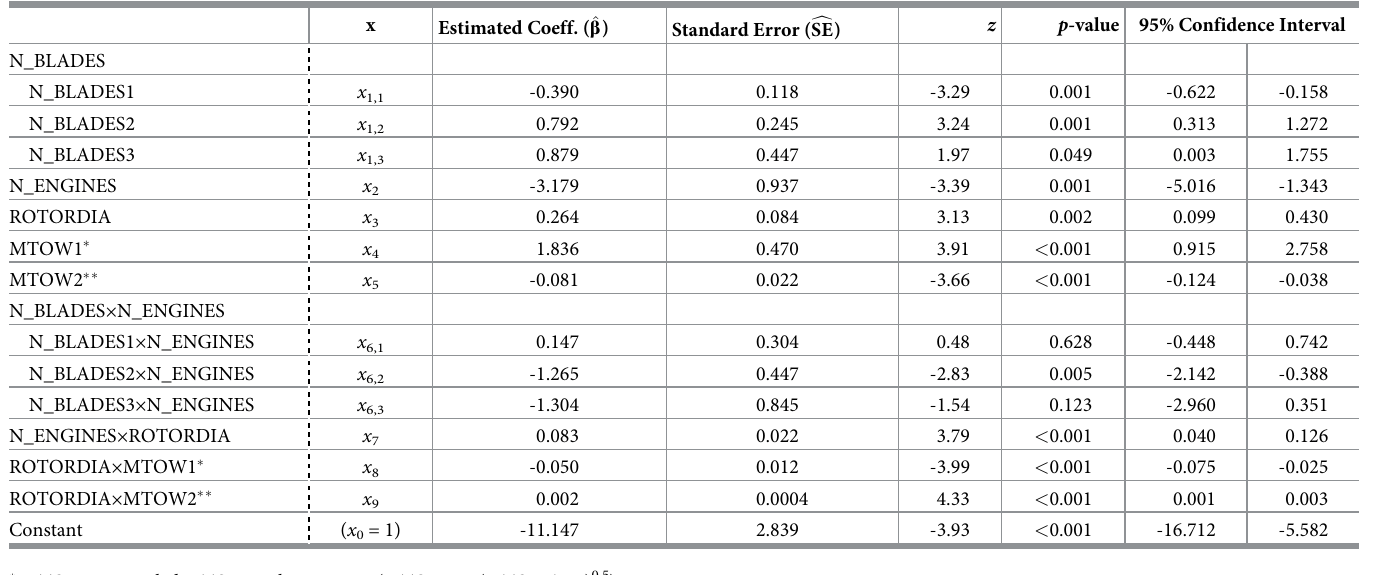
Table 5. Final model of turboshaft helicopter accidents with statistical